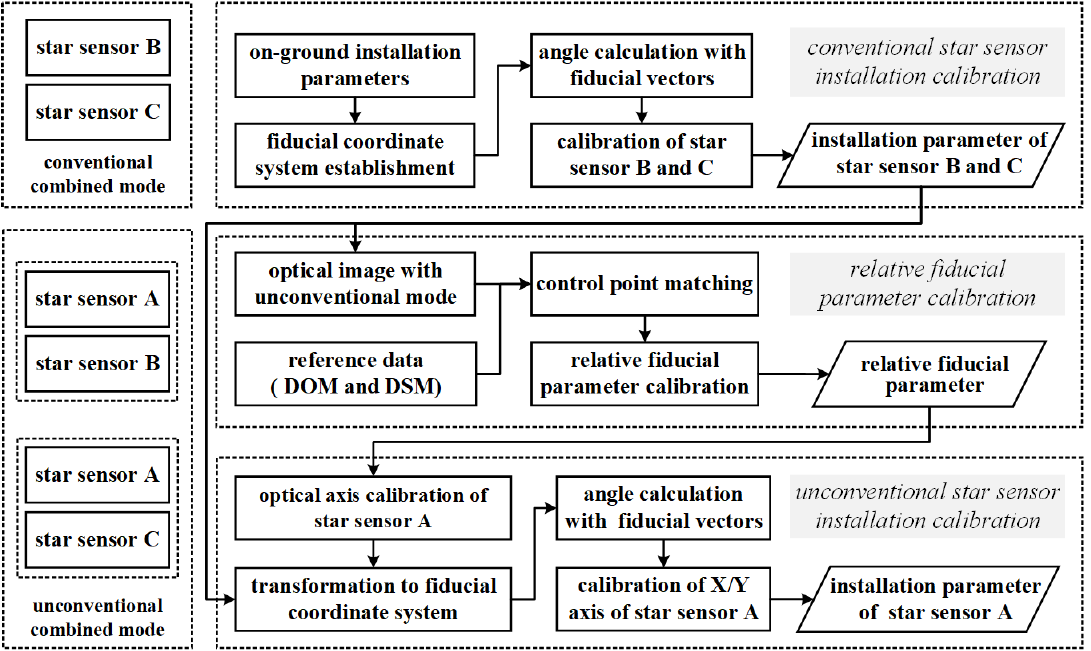
Figure 2. Flowchart of the proposed method for on-orbit calibration of installation parameters of the multiple star sensors system. Digital orthophoto maps (DOM) and digital surface model